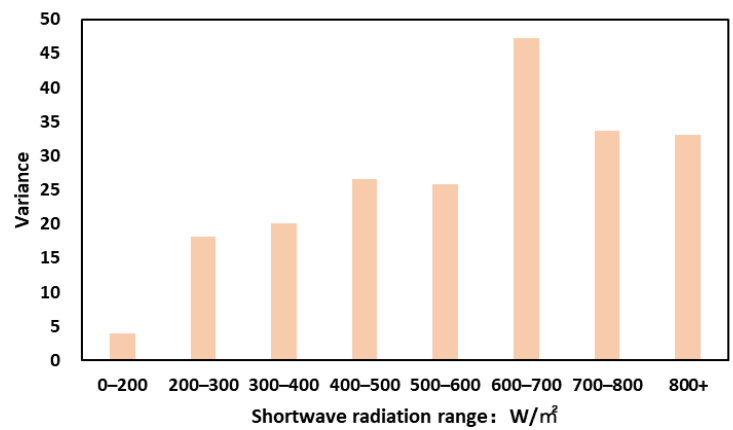
Figure 7. Data variance under different shortwave radiation bands.